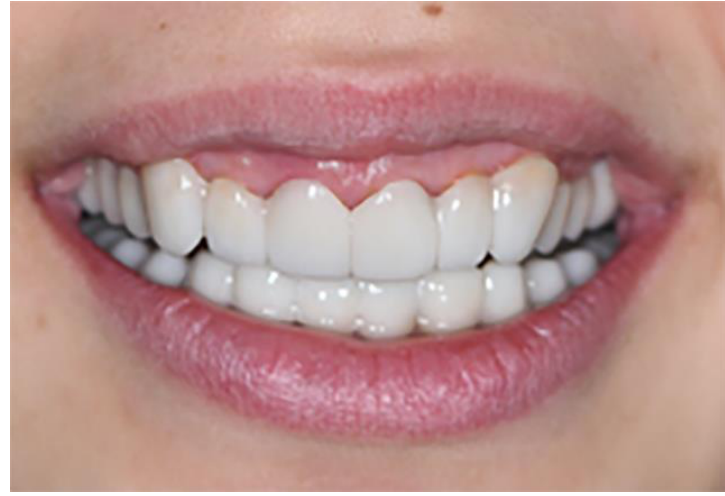
Figure 11. Case 3—Extraoral view of the patient with amelogenesis imperfecta wearing DEFS.